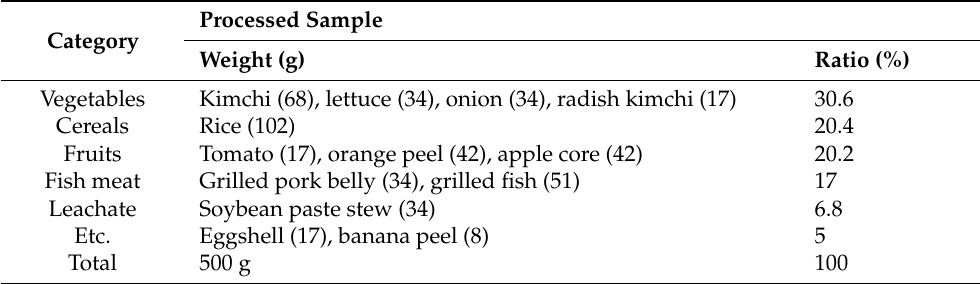
Table 1. Composition of sample used for